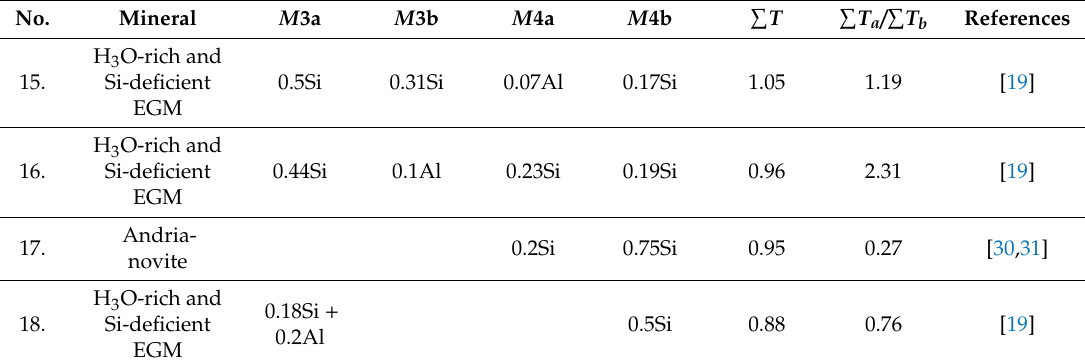
Figure 8. A fragment of the crystal structure of andrianovite. Figure 9. Blocky isomorphism in the M 3 and M 4 micro-regions of golyshevite viewed along (210).